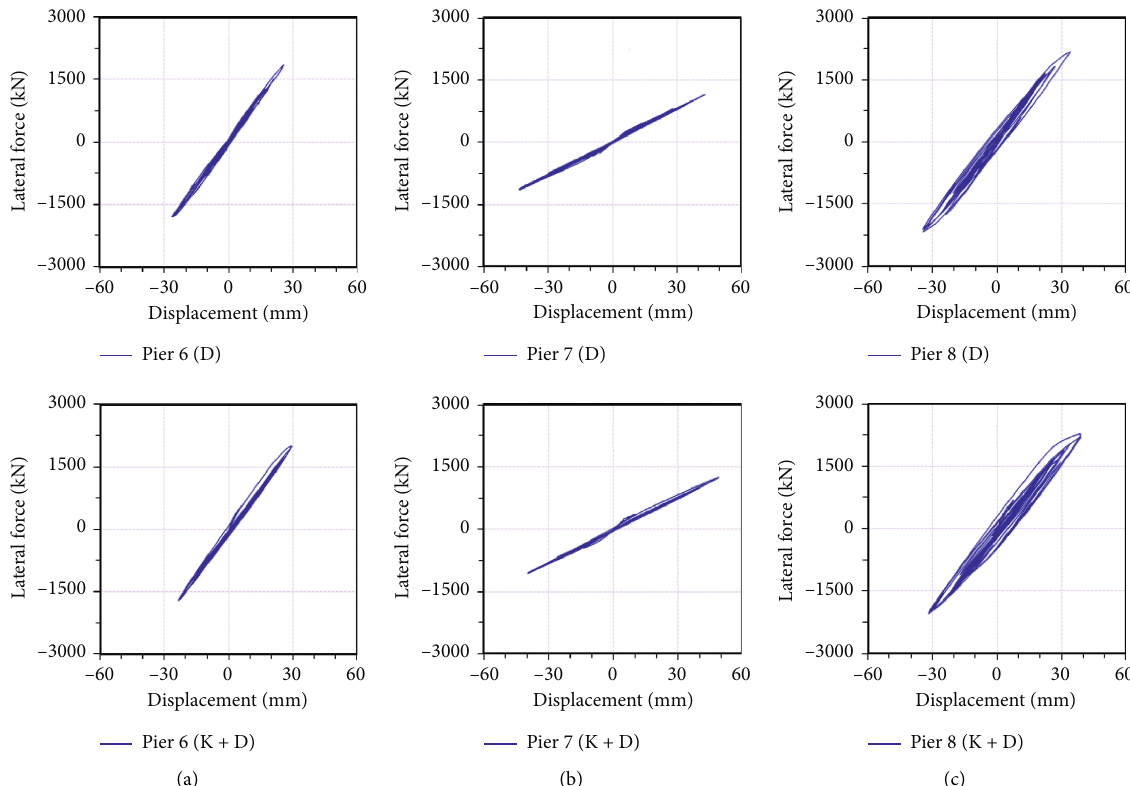
Figure 7: Transverse hysteretic response of the flexure-axial model subjected to biaxial input ground motions of D and K +D earthquakes. (a) Pier 6. (b) Pier 7. (c) Pier 8.